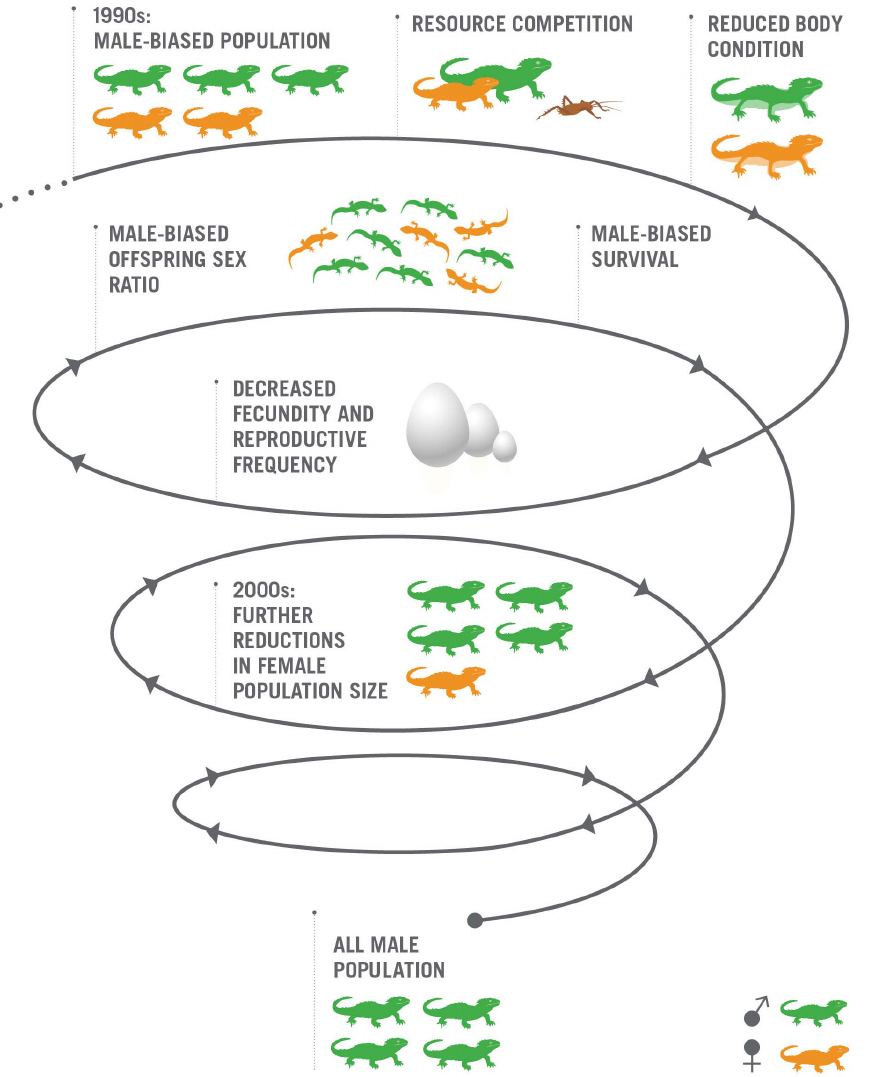
Figure 6. The extinction vortex in North Brother tuatara. The cumulative feedbacks from a male-biased sex ratio are reducing female numbers and driving an island population of tuatara towards becoming entirely composed of males and functionally extinct. Graphic designed by C. Foster.